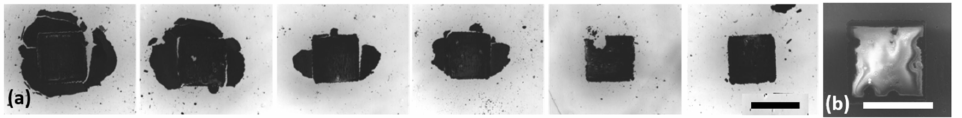
Figure 3. ( a ) CNW pixels transferred at different laser fluences, i.e., from left to right: 700, 650, 600, 550, 500, and 450 mJ/cm 2 . ( b ) SEM image of a CNW donor after LIFT at a 450 mJ/cm 2 laser fluence. The scale bar in both images, i.e., ( a , b ), is 500 µ